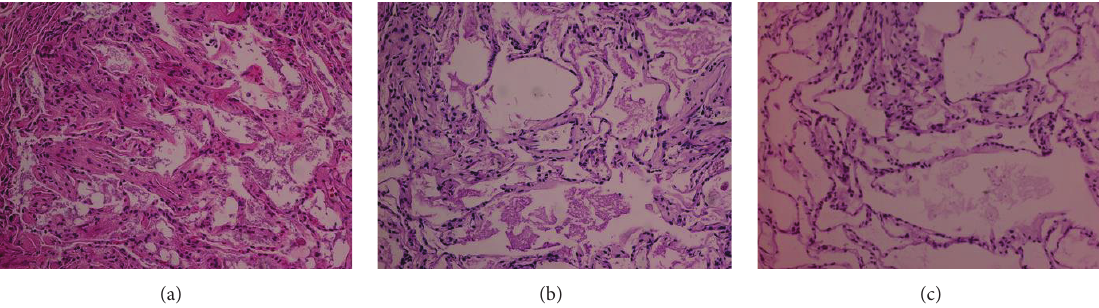
Figure 4: Samples obtained via transbronchial biopsy before initiation of everolimus therapy. (a) Pink granular material partially filling the airspaces, hematoxylin and eosin stain. (b) Eosinophilic material within airspaces, periodic acid–Schiff (PAS) stain. (c) Rare, small diastase- resistant globular inclusions, PAS stain with